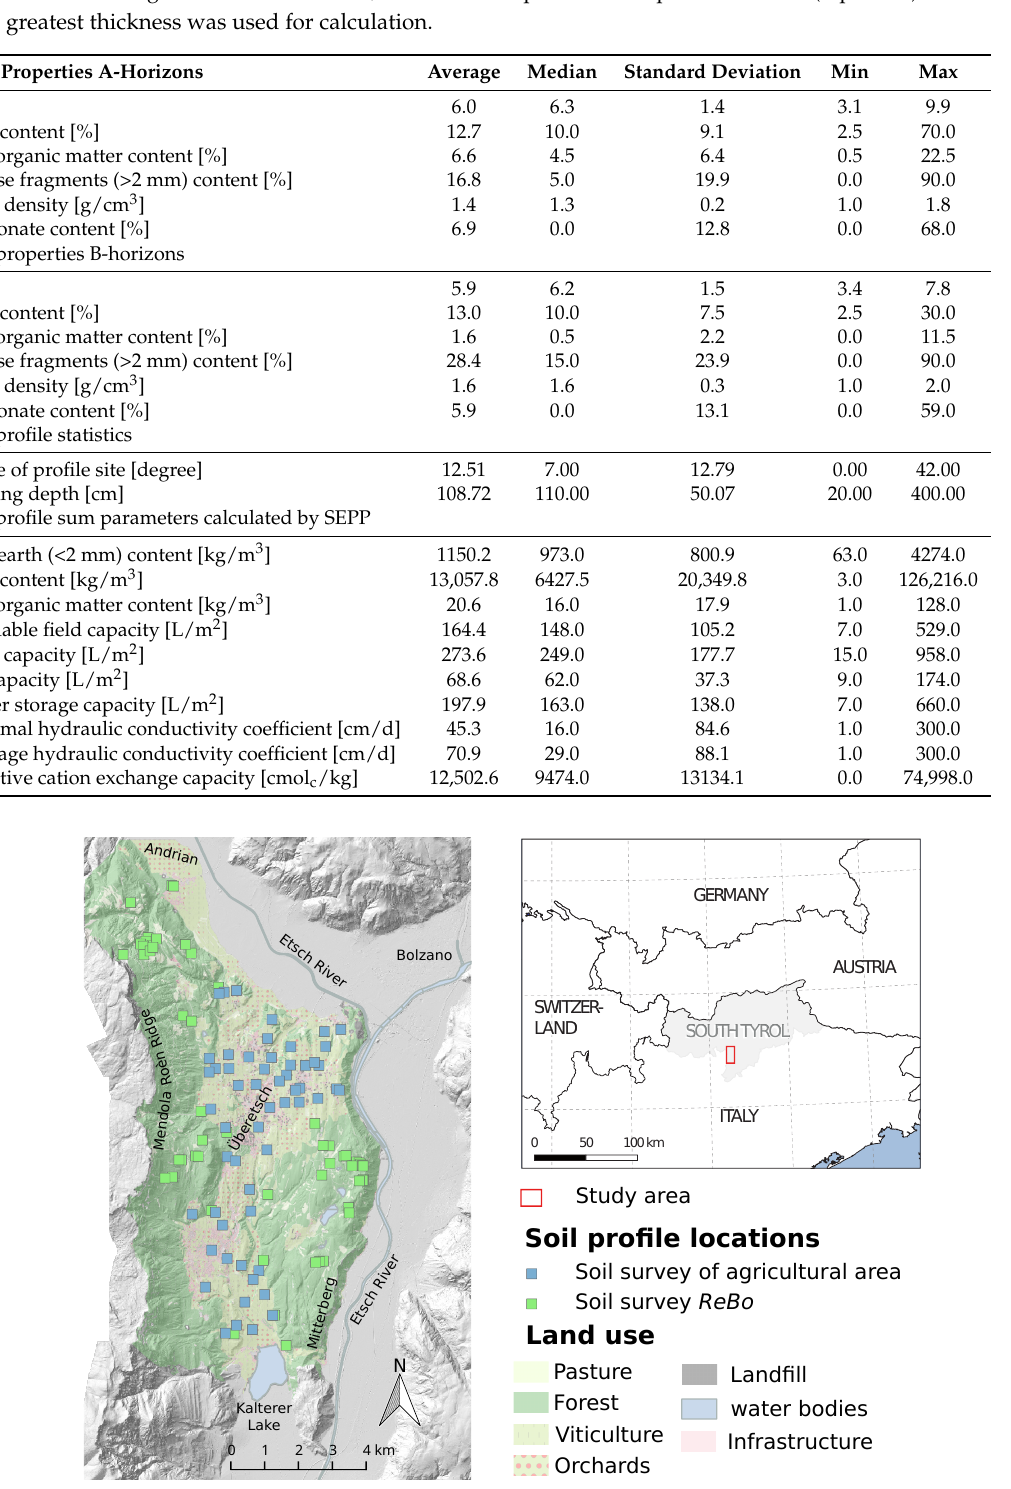
Figure 1. Study area located in the Autonomous Province of South Tyrol (Bolzano), as indicated by the red rectangle. Digital terrain model and land use data were provided by the Autonomous Province Bolzano—South